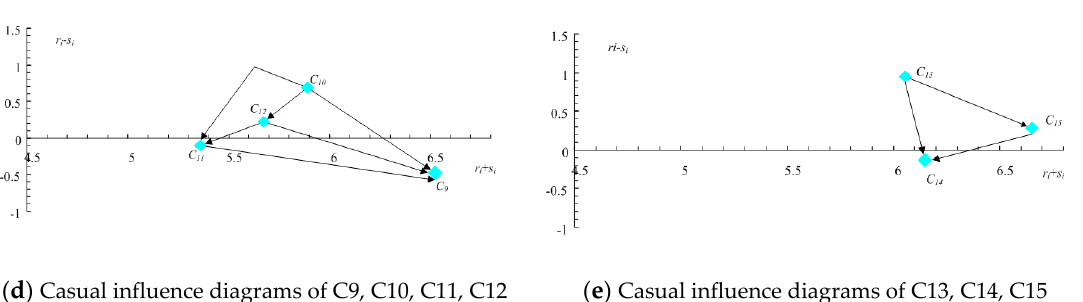
Figure 3. Causal influence diagram for dimensions and criteria.